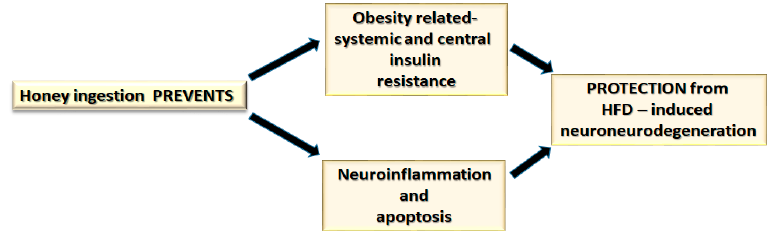
Table S2: Composition of